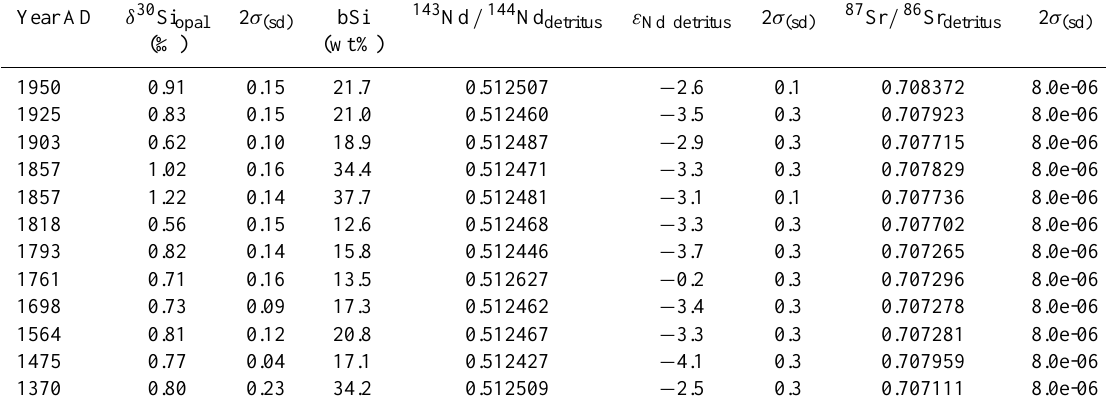
Table 2. Downcore records of core B0405-6 for δ 30 Si opal (‰); bSi content (wt%); and 143 Nd / 144 Nd, ε Nd and 87 Sr / 86 Sr of detrital material. 2 σ (sd) represents the external reproducibilities of repeated sample (Si) and standard (Nd, Sr)